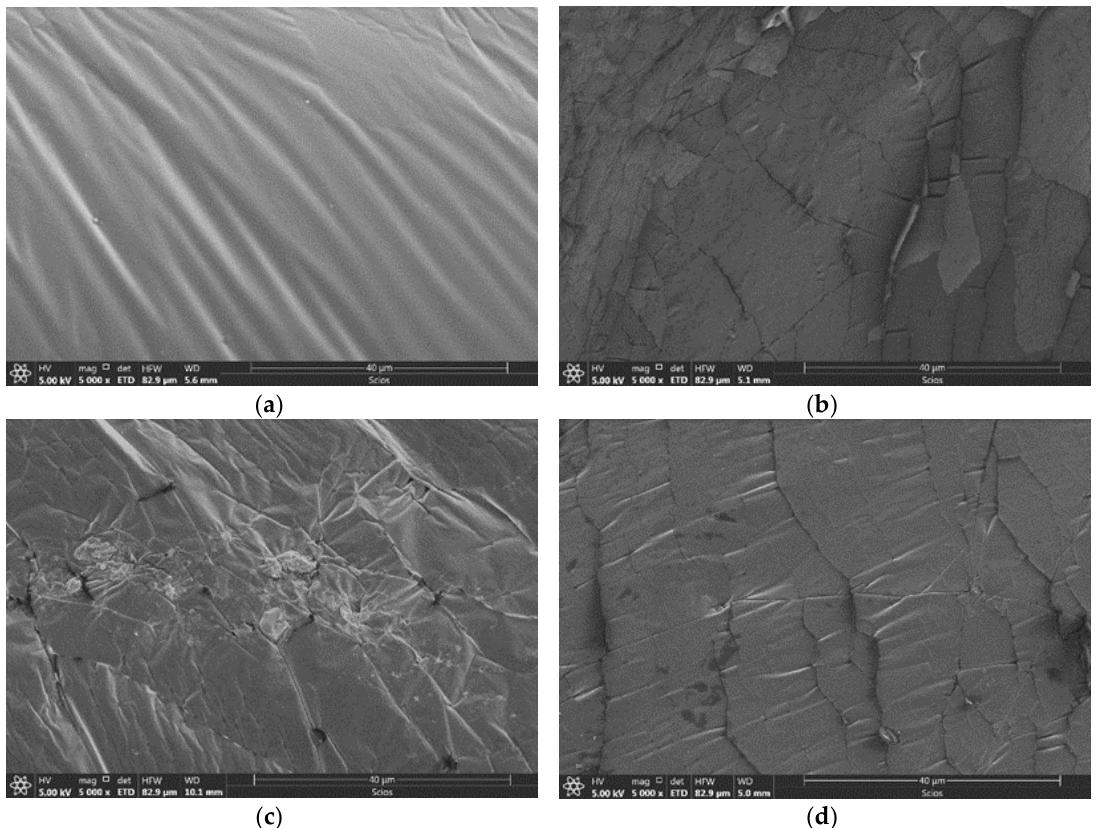
Figure 13. SEM images of base asphalt and foamed asphalt before and after F–T cycles at magnifications of ×5000. ( a ) 70# asphalt; ( b ) 70# asphalt after F–T cycles; ( c ) 70# foamed asphalt and ( d ) 70# foamed asphalt after F–T cycles